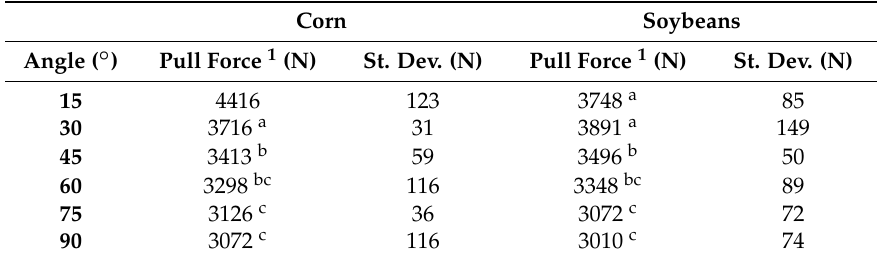
Table 2. Peak extrication force (in newtons w/standard deviation) required to free the mannequin entrapped at specific angles in corn and soybeans at a depth of 1.85 m.